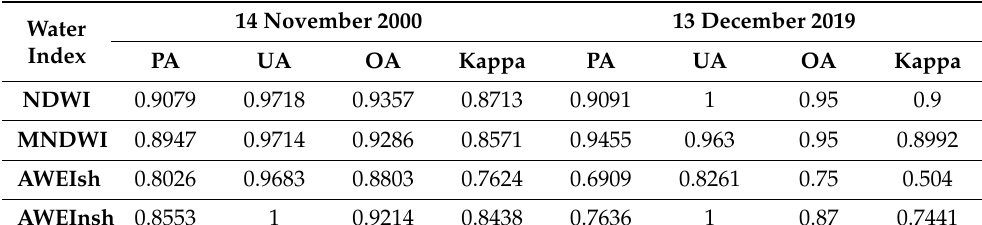
Table 10. Xiuguluan River: Accuracy of spectral water body indices in terms of water body extraction on different dates.